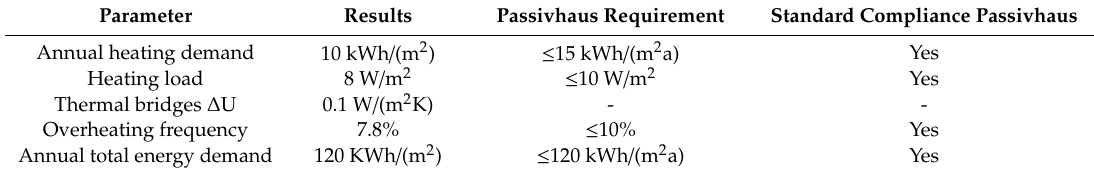
Table 2. Results and verification of compliance requirements Passivhaus (see Appendix